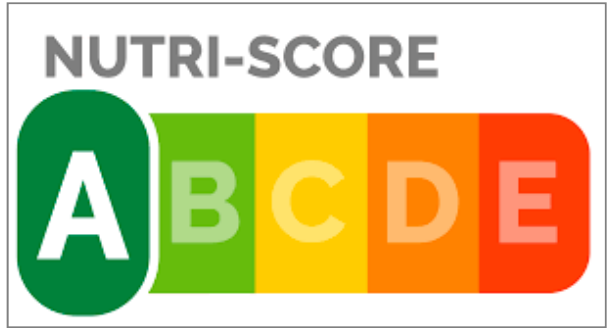
Figure A6. Nutri-Score (France) is a graphic scale that divides the nutritional score into five classes (expressed by a colour and a letter), based on the food’s content of energy, sugars, saturated fat, sodium, fruit, vegetables, nuts, fibre, and protein per 100 g or 100 mL (Algorithm based on UK Food Standards Agency Nutrient Profiling system with minor modifications for cheese, added fats, and beverages). Developed under the aegis of the French government, Nutri-Score is now in use in Belgium, Spain, Germany, the Netherlands and Luxembourg.